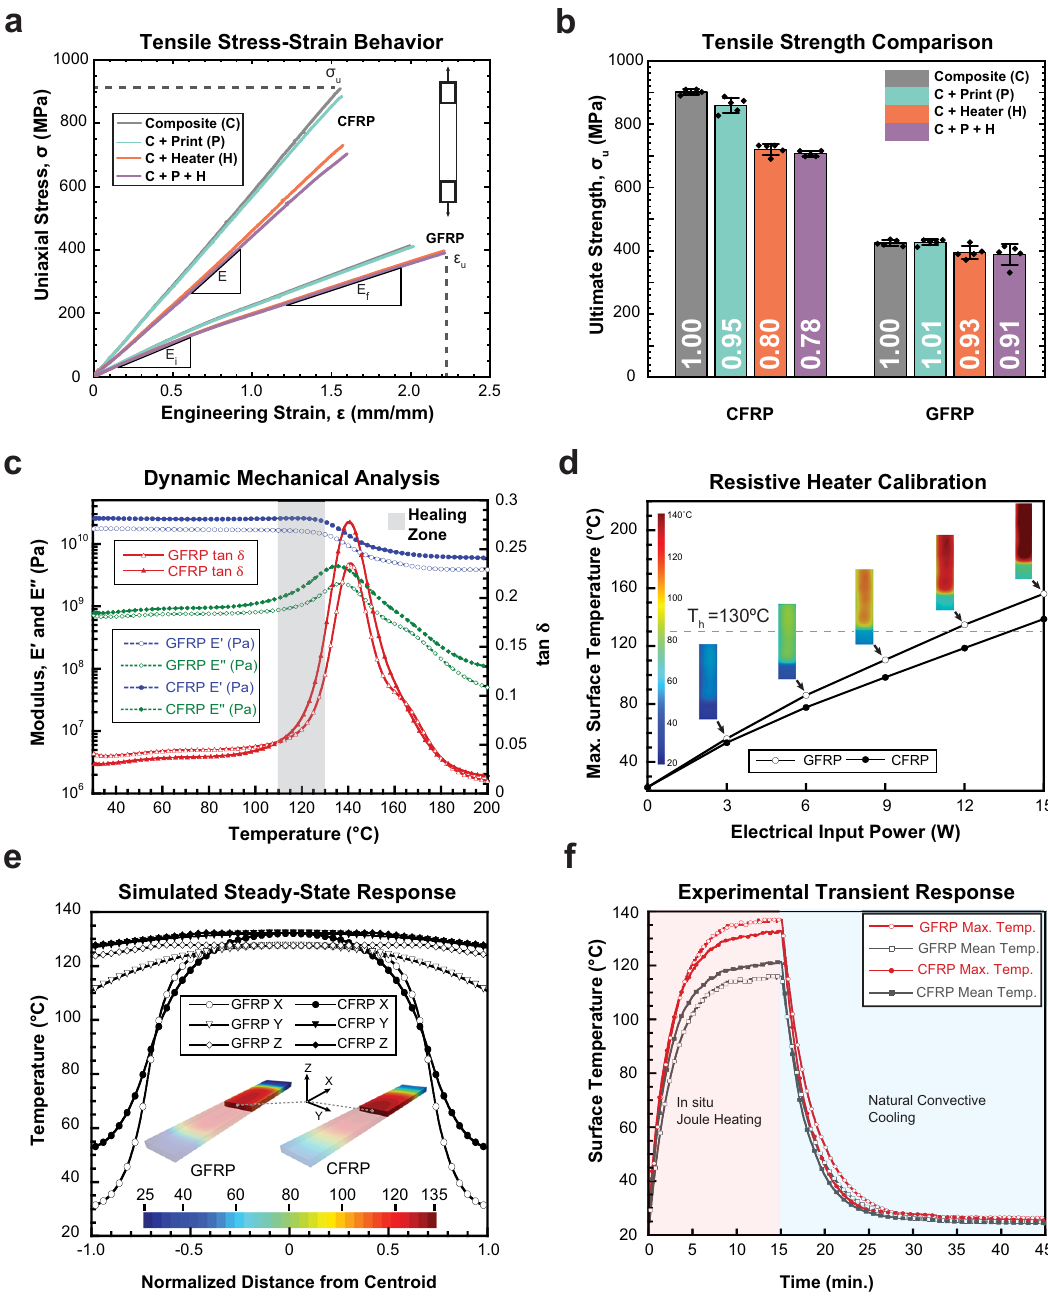
Fig. 3 | Thermo-mechanical material characterization. a Uniaxial tensile response for various glass- (GFRP) and carbon- fi ber (CFRP) composite lami- nates, including plain and permuted con fi gurations with printed EMAA mid- layer and resistive heaters. b Failure strength summary of composite lami- nates in ( a ); numbers at the bottom of the bar plots indicate the normalized strength values in reference to plain composite controls. Error bars represent the standard deviation from the mean ( n = 5). c Dynamic mechanical analysis (DMA)behaviorforGFRPandCFRPcompositeswithmatchingglass-transition